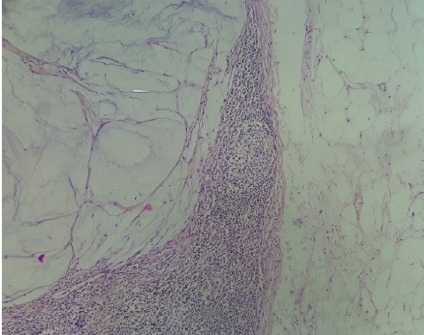
Figure 2: H&E staining showing a necrosis effect on lymph node after neoadjuvant treatment (magnification: × 200).